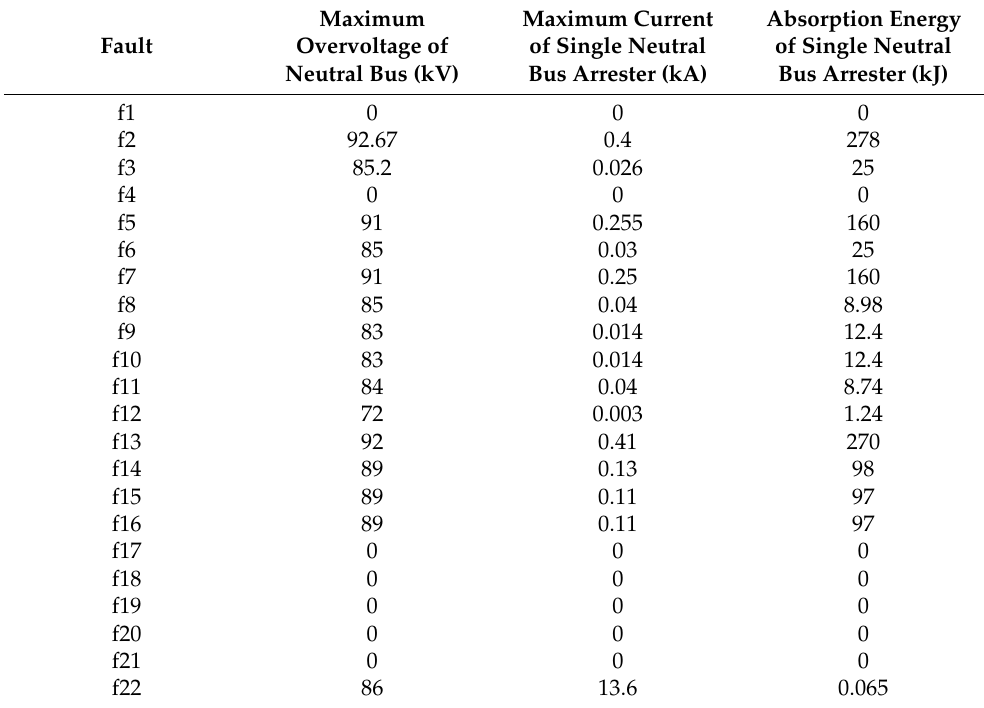
Table 5. Arrester voltage, current, and energy of different fault conditions under symmetric monopole operation mode.